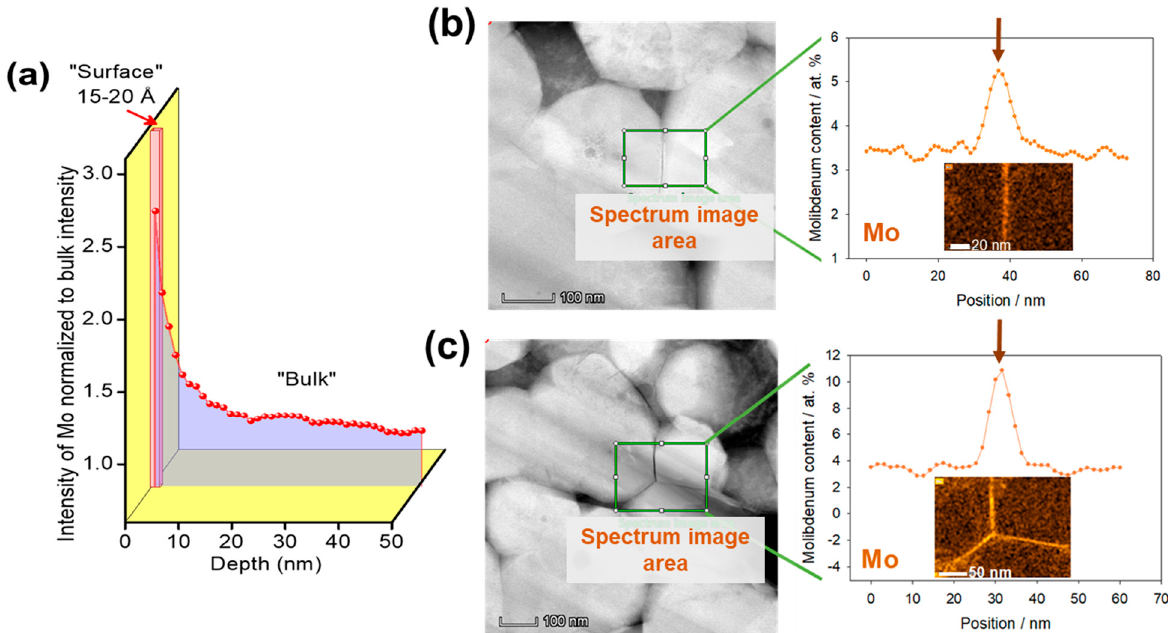
Figure 3. ( a ) The depth profiles of Molybdenum obtained from ToF-SIMS studies of NCM85 Mo-doped material demon- strating the dopant segregation at the outermost surface layer of ~15–20 Å. Note that due to high roughness of the powder NCM85 samples, “surface” and “bulk” regions are shown only schematically, as an eye guide. ( b , c ) HAADF-STEM images and the corresponding EDX maps of the Mo-K α measured from NCM85 Mo-doped material demonstrating the enrichment of the grain boundaries with the dopant. Spectral image areas are shown with green-line rectangles. The grain boundaries are marked with arrows.